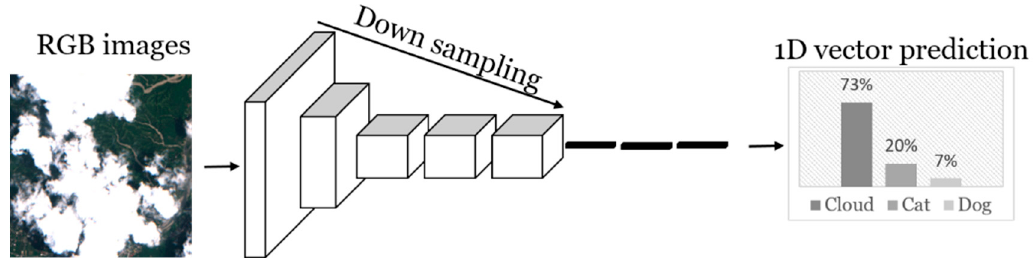
Figure 4. Illustration of convolutional neural network (CNN) architecture for cloud classification.